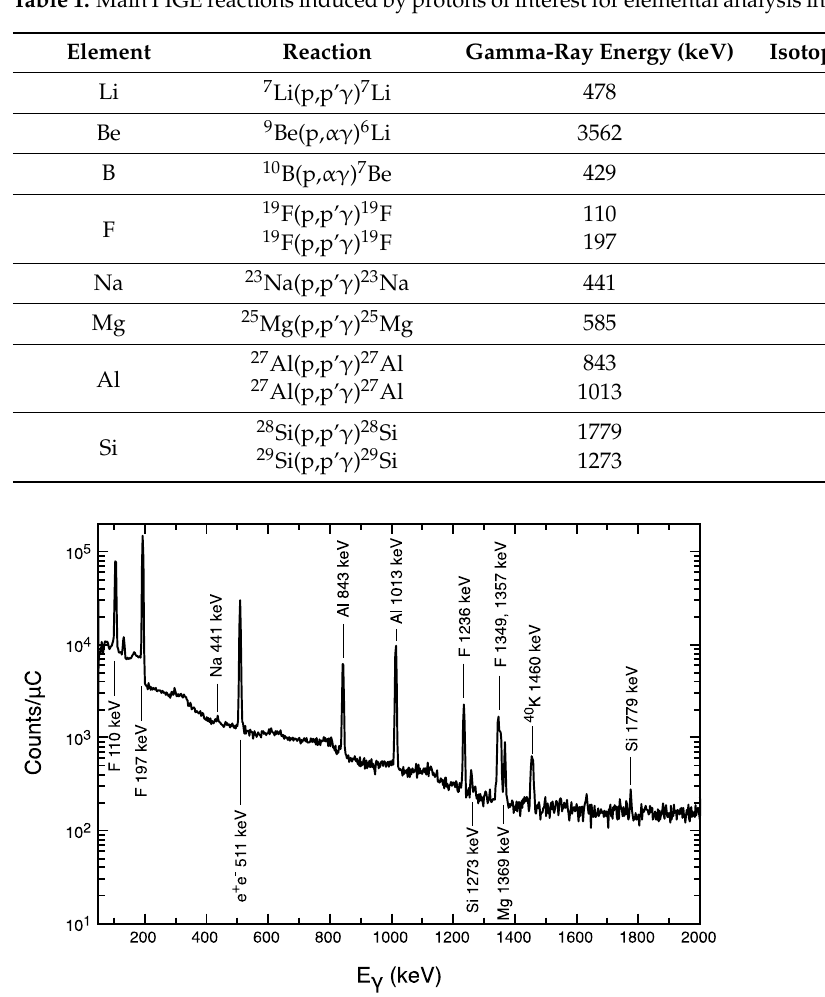
Figure 4. PIGE spectrum of a topaz obtained with 3 MeV protons, showing gamma-ray lines of F, Na, Al, Mg, and Si. The spectrum is normalised by the proton beam charge accumulated during the measurement. Table 1. Main PIGE reactions induced by protons of interest for elemental analysis in cultural heritage.